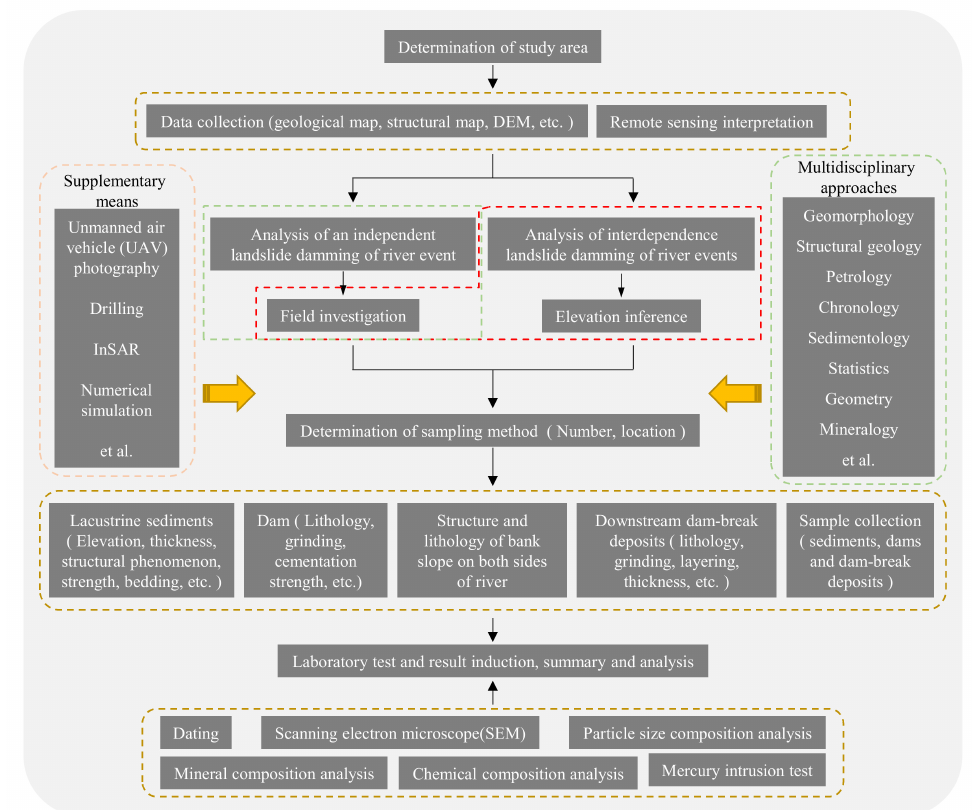
Figure 16. The general flow chart of studying the river blocking